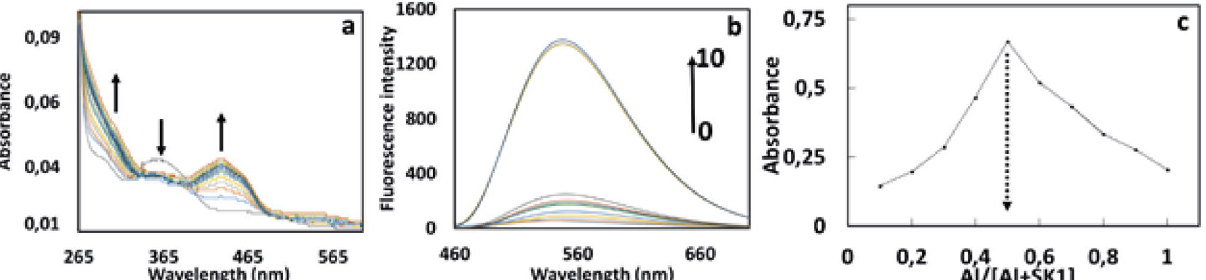
Fig. 4. (a) UV-Vis, (b) fluorescence titration spectra of compound SK-1 (1µM) respectively, upon addition of Al 3+ (from 0 to 10 equiv.) at room temperature (λ ex = 430 nm; λ em = 530 nm) and (c) Job’s plot for the determination of stoichiometry of SK-1-Al 3+